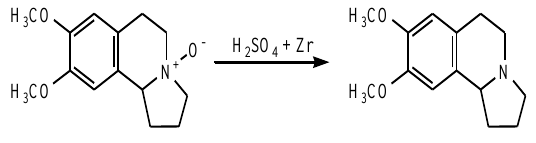
Figure 2. Deoxygenation of crispine A N-